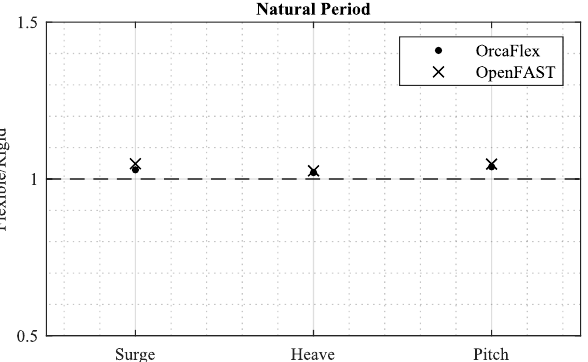
Figure 5. Comparison of natural periods in surge, heave, and pitch. The rigid model is modeled in OrcaFlex.